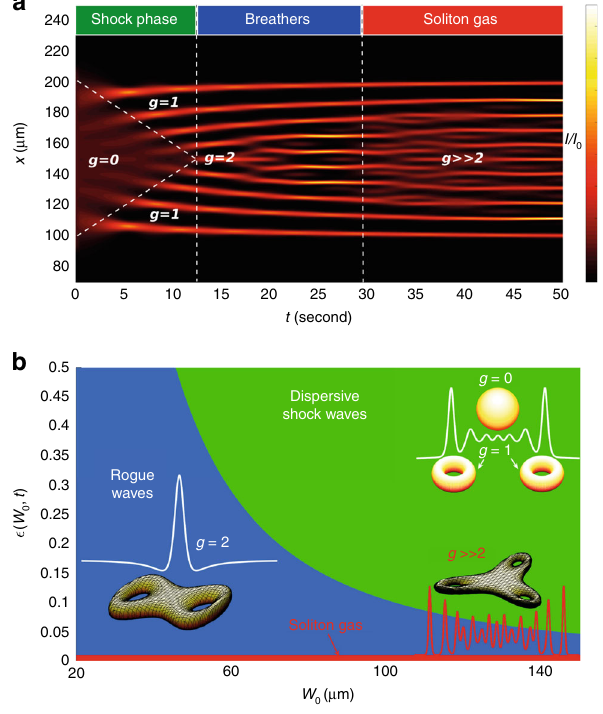
Fig. 1 Topological classi fi cation of extreme waves. a Final states of the wave for a fi xed initial waist W 0 ¼ 100 μ m showing the generation of focusing dispersive shock waves ( g ¼ 1), rogue waves ( g (cid:2) 2), and a soliton gas ( g >> 2) after different time intervals in a photorefractive material (see text). b Phase diagram reporting the fi nal states in terms of the parameter ϵ and the initial beam waist. Transitions occur by fi xing waist and varying ϵ or, equivalently, the observation time t . Different surfaces displayed in proximity of the various wave pro fi les, corresponding to the different regions in the phase diagram, outline the link between the topological classi fi cation of extreme waves in terms of the genus g and the topological classi fi cation of toroidal Riemann surfaces (for a sphere, g ¼ 0, for a torus, g ¼ 1,